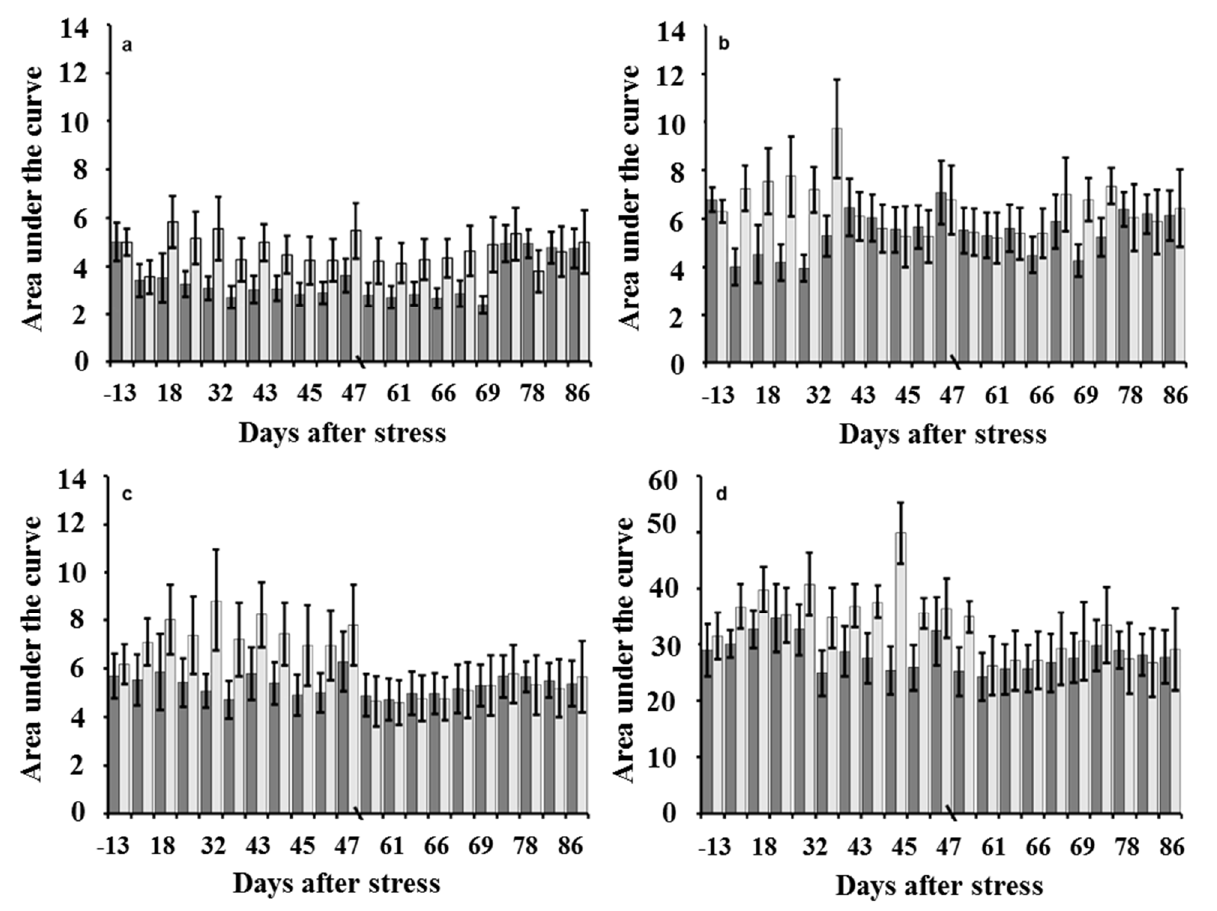
Figure 4. The mean and standard deviations of the area under the curve for SWIR regions: bars are the control group, and the light ones are the stressed treatment. Error bars are the standard deviation. The break in the horizontal axis between 47 and 52 days after stress separates the period of water stress from recovery; n = 168. Avg is the average; Sd . is the standard